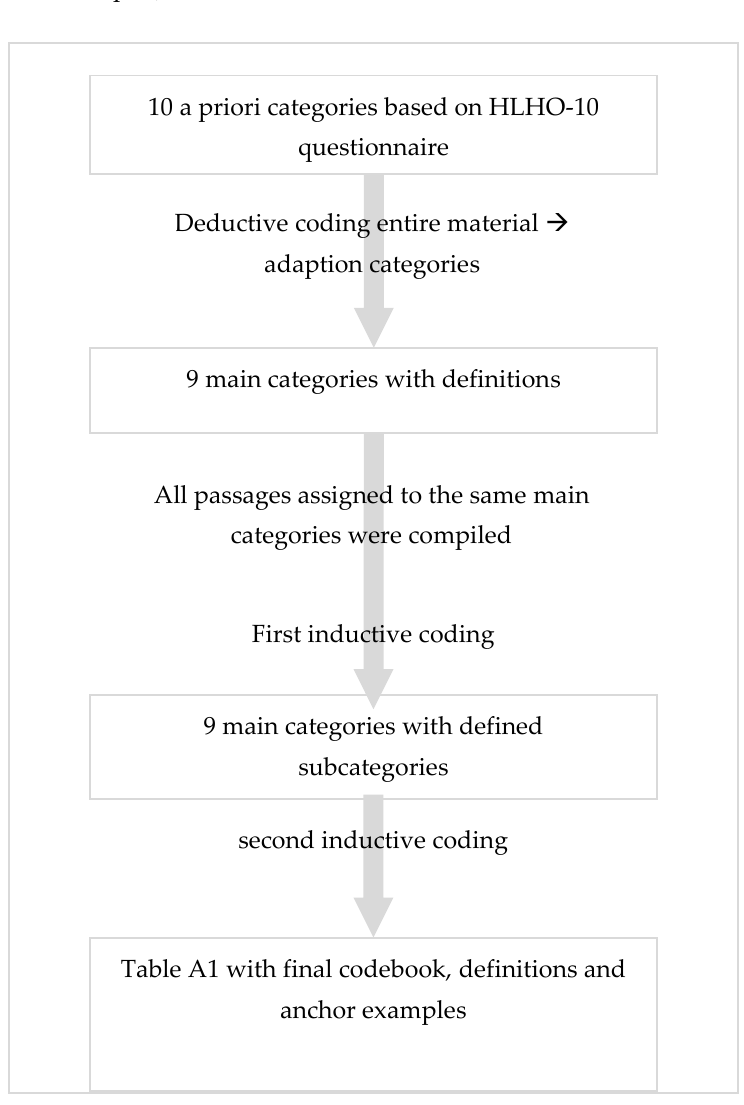
Figure 1. Coding procedure (separate display).